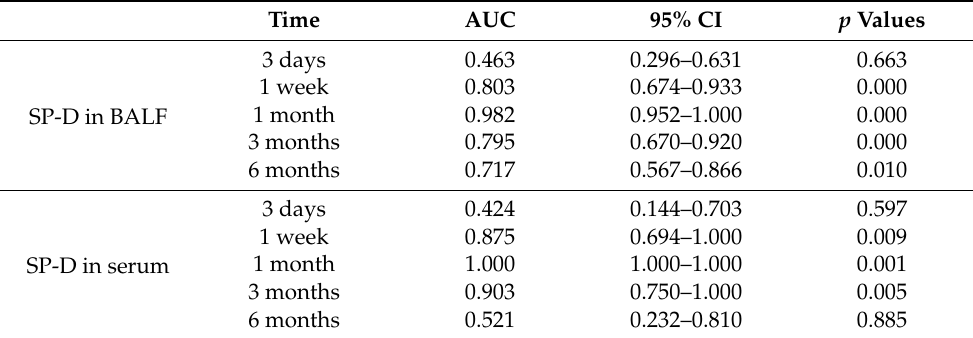
Figure 8. The receiver operating characteristics (ROCs) for the toxicity of nanomaterials by SP-D concentration in BALF and serum. ( A ) ROC curve of SP-D in BALF (n = 250). ( B ) ROC curve of SP-D in serum (n = 97). Table 2. Result of ROC analysis in intratracheal instillation of nanomaterials.